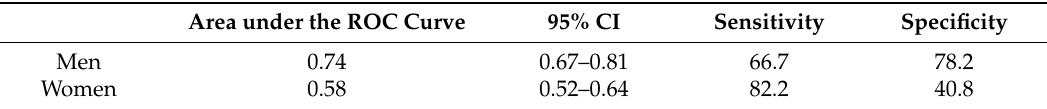
Table 2. Areas under the ROC curve, confidence interval (95% CI) and the respective values of sensitivity and specificity of the time exposed to sedentary behaviour as a predictor of frailty in older adults.